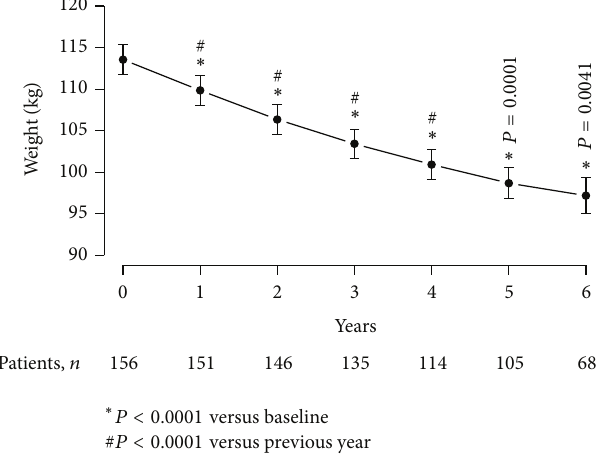
Figure 2: Weight (kg) in 156 obese hypogonadal men with type 2 diabetes mellitus treated with testosterone undecanoate injections for up to 6